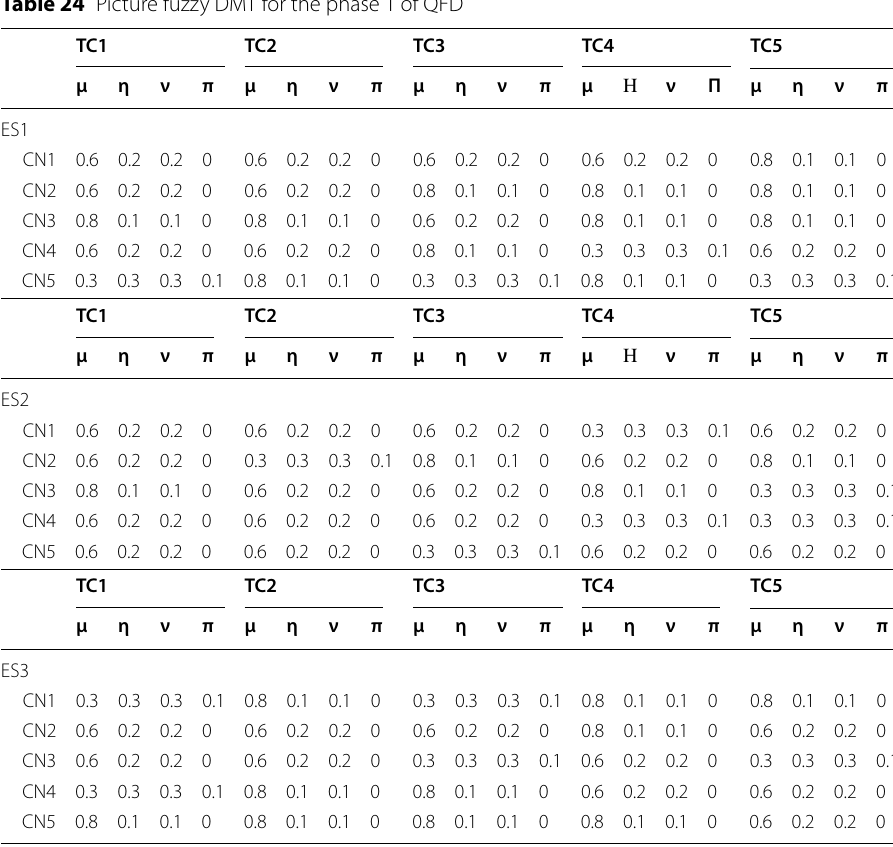
Table 24 Picture fuzzy DMT for the phase 1 of QFD